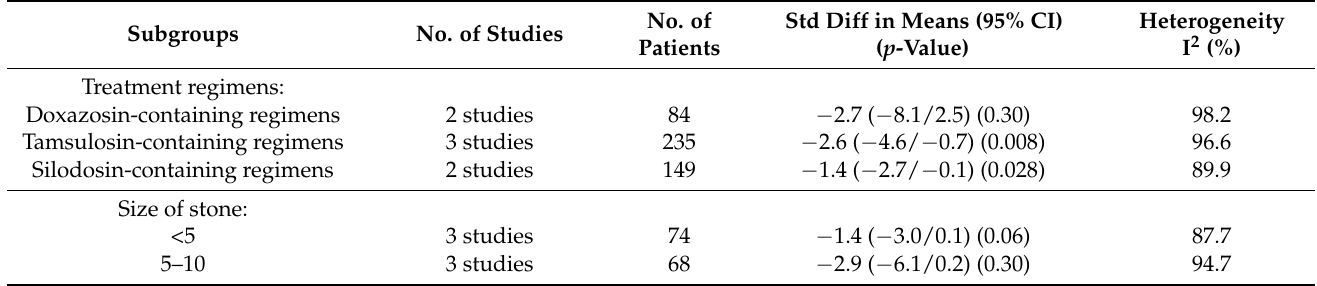
Table 3. Pooled differences in stone expulsion time among subgroups of treatment regimens and sizes of stones.